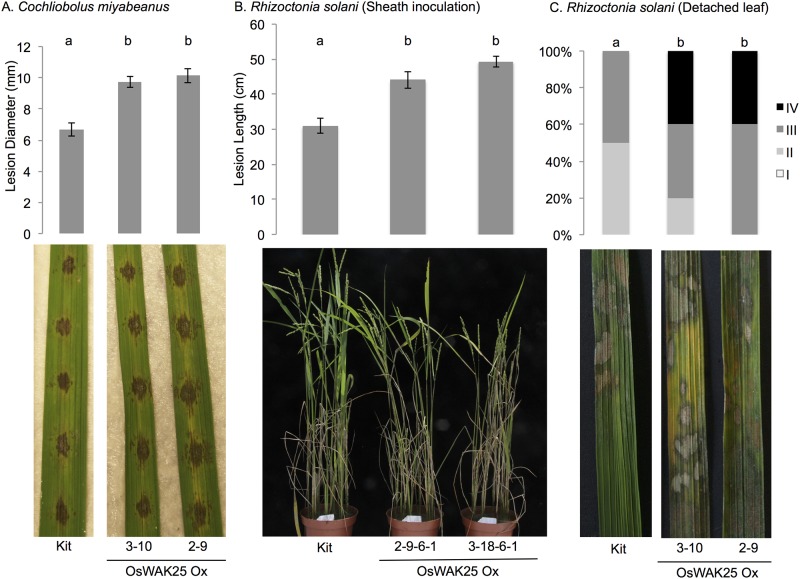
OsWAK25 overexpression plants are more susceptible to Cochliobolus miyabeanus and Rhizoctonia solani.(A) The fifth and sixth leaves were detached from six-week old plants and used for infection. Pictures and measurements were taken 3 dpi. (B) Photos and measurements were taken 14 dpi. R. solani sheath inoculation was conducted on six-week old plants. (C) Detached leaves from six-week old plants were infected with R. solani and disease leaf area (DLA) was scored after 3 days into 4 classes: Class I DLA < 25%, Class II 25% < DLA < 50%, Class III 50% < DLA <75%, Class IV DLA > 75%. Bars with different letters indicate statistical significance (p < 0.01) as determined by ANOVA with Tukey-Kramer post-hoc test for (A) and (B) and the Kruskal-Wallis test for (C). Both detached leaf experiments were conducted twice with similar results and data from one representative experiment shown. The sheath inoculation assay was conducted once.